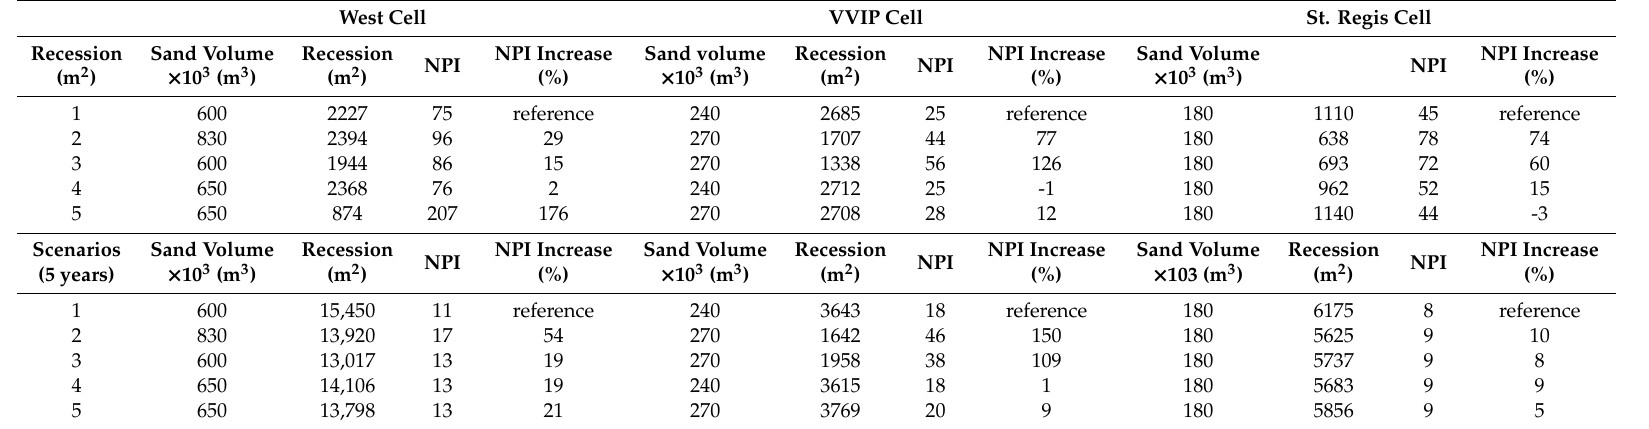
Table 6. nourishment performance index (NPI) values at Saadiyat